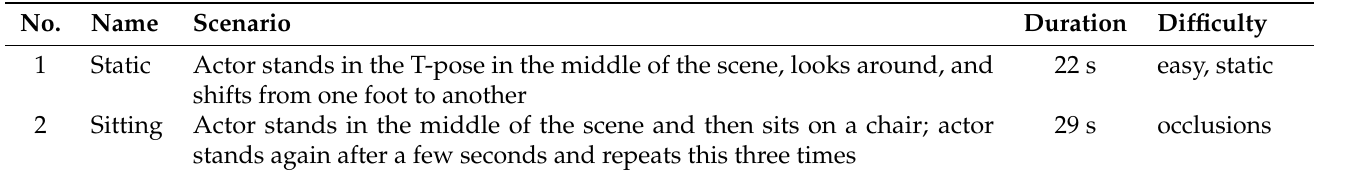
Table 1. List of mocap sequence scenarios used for the